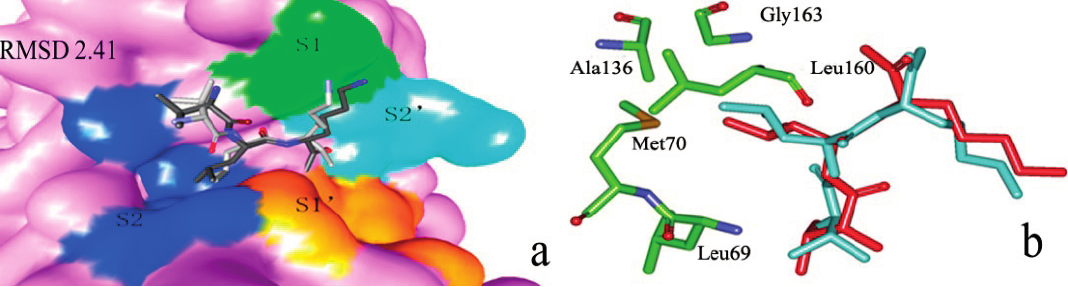
Figure 5. ( a , c , e ) Surface representation of the substrate binding sites of inhibitor E64. Dark blue color represents S2 pocket, and green color represents S1 pocket, calculated by Autodock Vina (Molecular Graphics Laboratory, La Jolla, CA, USA), Autodock 4.2 (Molecular Graphics Laboratory), Dock 6.6 (University of California, San Francisco, CA, USA), respectively; ( b , d , f ) The S1, S2, S1', and S2' residues around the docked ligand and the reference for the crystal structure (red), calculated by Autodock Vina, Autodock 4.2, Dock 6.6 ,